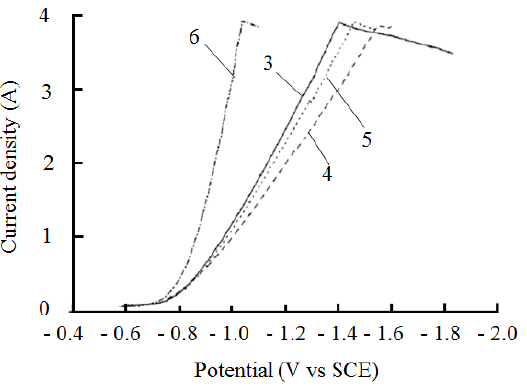
Figure 5. Cathodic polarization curves of nickel ions at different pH values in the plating solution.